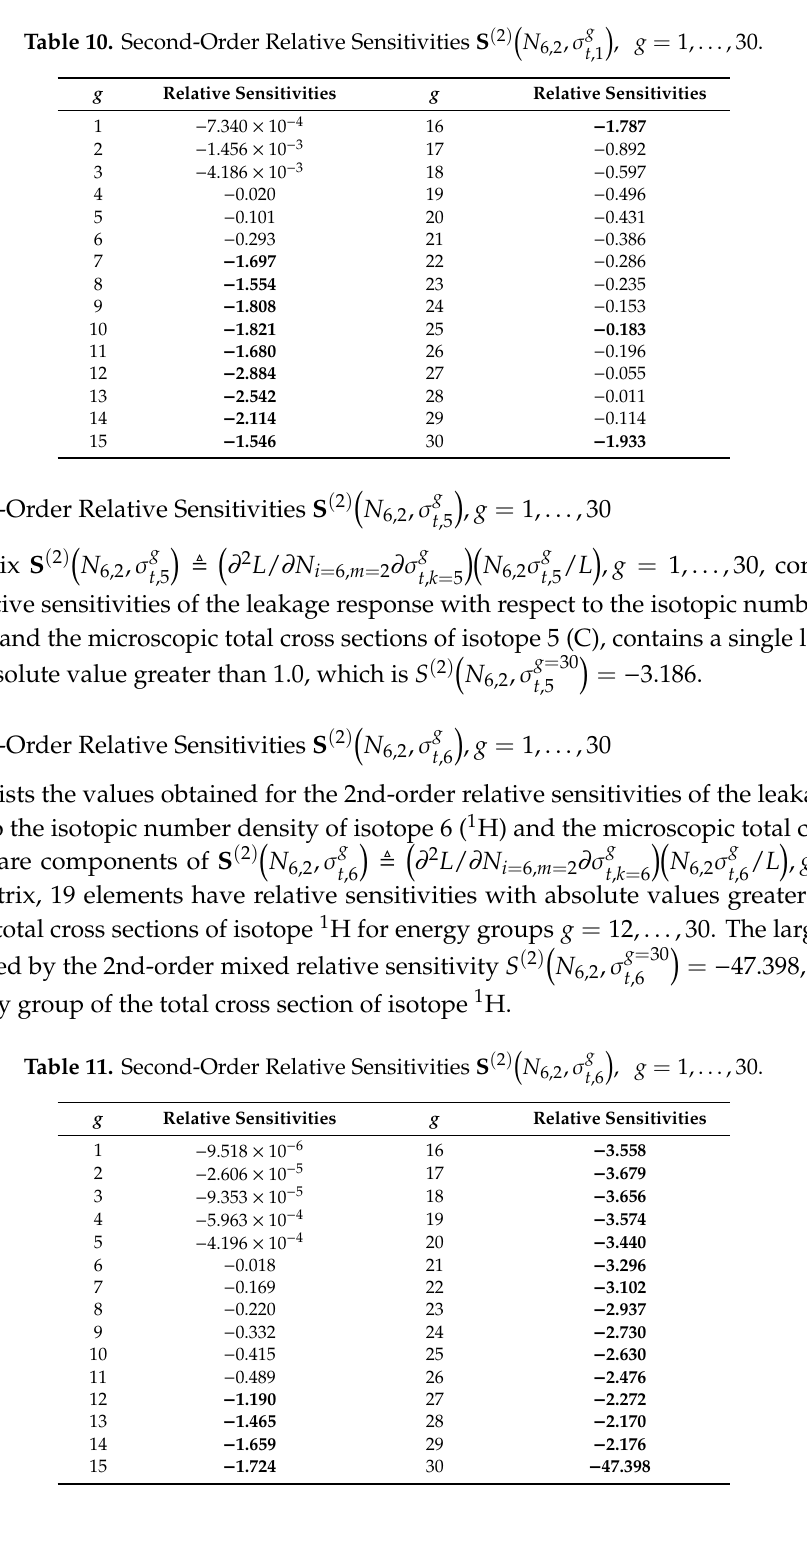
(cid:16) (cid:17) N 6,2 , σ g , g = 1, ... ,30. t ,1